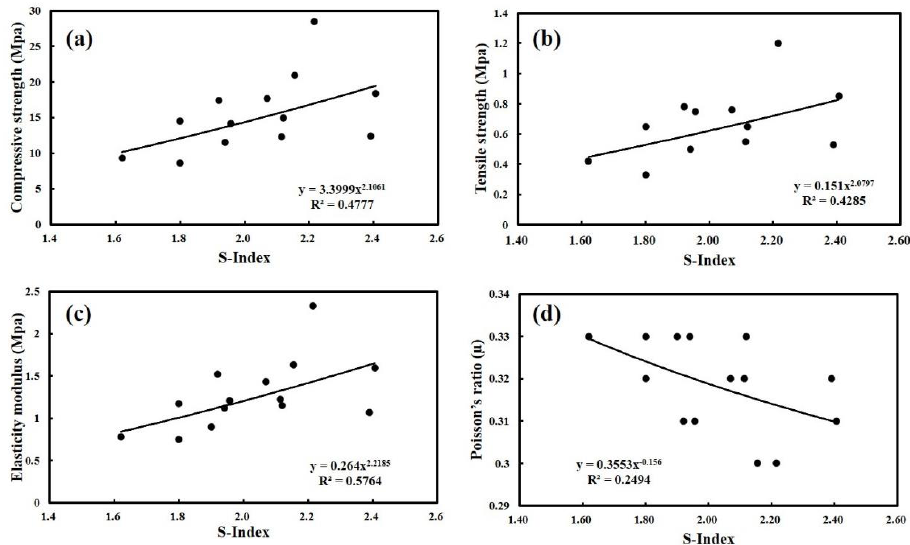
Figure 12. Relationship between S-Index and coal rock mechanics parameters. ( a ) Relationship